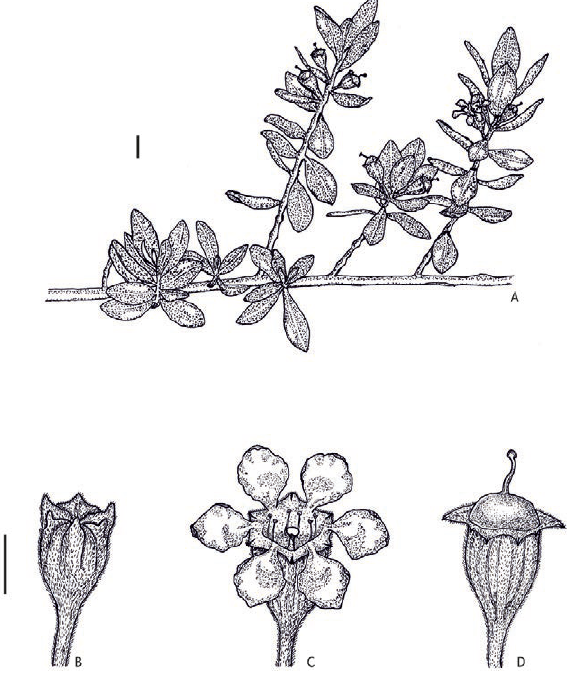
Figure 1. Pemphis acidula J.R. Forst. & G. Forst. (Lythraceae). A - Flowering shoot; B - Flower bud; C - Flower; D - Fruit. Scale: A = 10mm; B-D = 5 mm. (Material from Sir William Peel Island, Ritchie’s Archipelago, Andaman Islands (M.P. Goutham Bharathi and Titus Immanuel, 31019 (PBL); Drawn by Titus Immanuel).